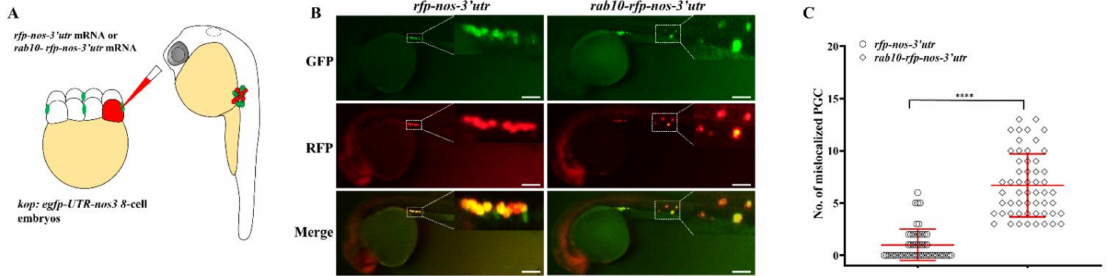
Figure 5. PGC-specific overexpression of rab10 leads to PGC mislocalization. ( A ) rab10-rfp-nos-3 (cid:48) utr mRNA was injected into 8-cell embryos of kop: egfp-UTR-nos3 lines. ( B ) Representative images of PGCs in embryos injected with rfp-nos mRNA or rab10-rfp-nos-3 (cid:48) utr at prim 5 stage. ( C ) The number of mislocalized PGCs in each embryo injected with rfp-nos mRNA or rab10-rfp-nos-3 (cid:48) utr at prim 5 stage. The results were representative of more than three independent experiments in triplicate. The average number of mislocalized PGCs were showed in red line by mean ± sd. **** p < 0.0001. Scale bar, 100 µ